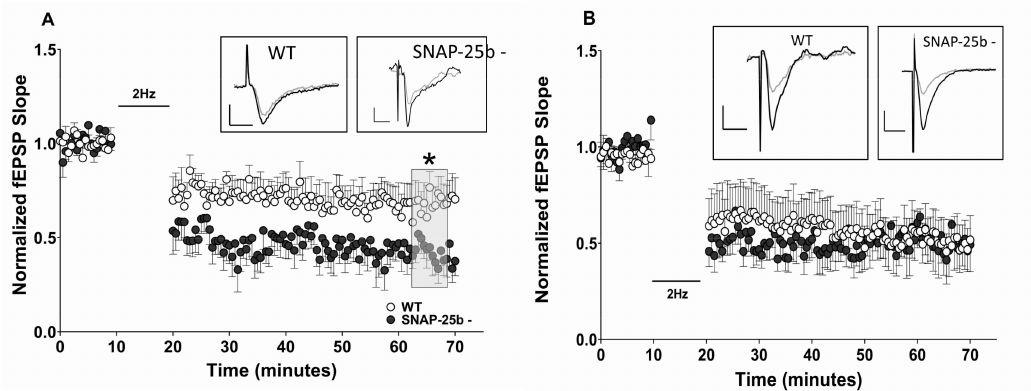
Figure 3. Changes in LTD at Scha ff er collateral-CA1 synapses in hippocampal slices from one and four month old SNAP-25b-deficient mice of both sexes. ( A ) LTD at one month of age at Scha ff er collateral-CA1 synapses induced by a 2Hz LFS. SNAP-25b-deficient mice (filled circles, n = 8) exhibited significantly greater LTD compared to controls (open circles, n = 7). Bar indicates application of LTD stimulus (2Hz / 10min, data points not shown). (* p < 0.01; Student’s t-test). Each point is normalized to the averaged baseline and is mean ± SEM of n slices. ( B ) After prolonged absence of SNAP-25b, four month old SNAP-25b-deficient mice (filled circles, n = 8) displayed LTD similar to WT littermates (open circles, n = 8). Each point is normalized to the averaged baseline and is mean ± SEM of n slices. LTD was calculated as mean of grey box, compared to pre-TBS normalized baseline. Insets: Representative Scha ff er collateral-evoked fEPSPs in WT and SNAP-25b deficient slices immediately before (black traces) and 50 min after (grey traces) LBS stimulation, with all calibration bars 1mV /